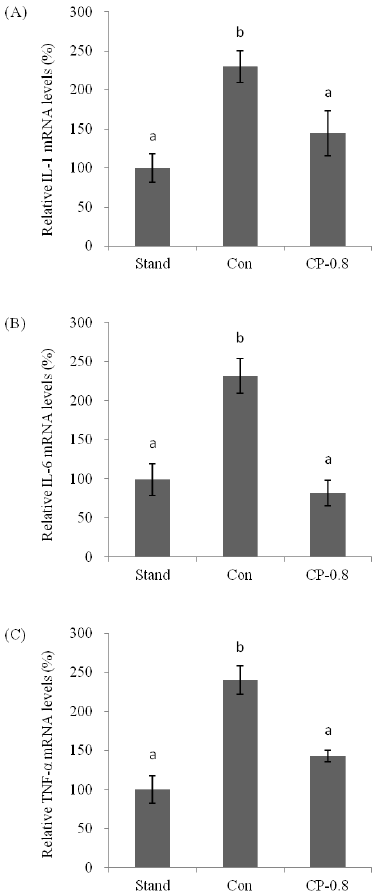
Figure 5. The effects of CPs on the mRNA expression of IL-1 ( A ), IL-6 ( B ), and TNF- α ( C ) in mice liver at 12 h after ethanol treatment. Values are expressed as means ± SEM ( n = 5 – 10). Values with different letters are significantly different at p < 0.05.